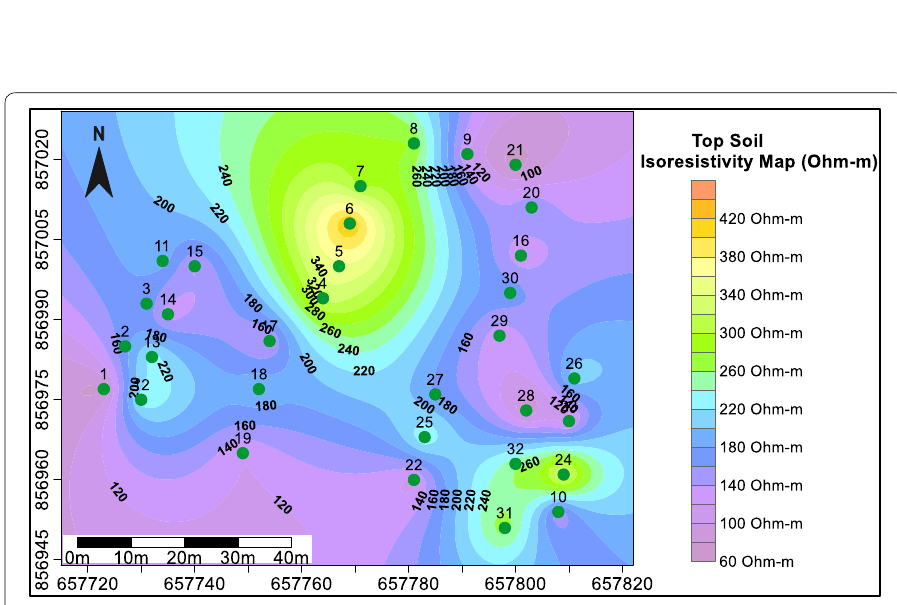
Fig. 15 Isoresistivity map of the